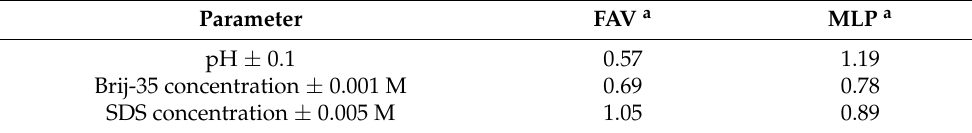
Table 6. Robustness of the proposed HPLC methods for the determination of FAV and MLP.